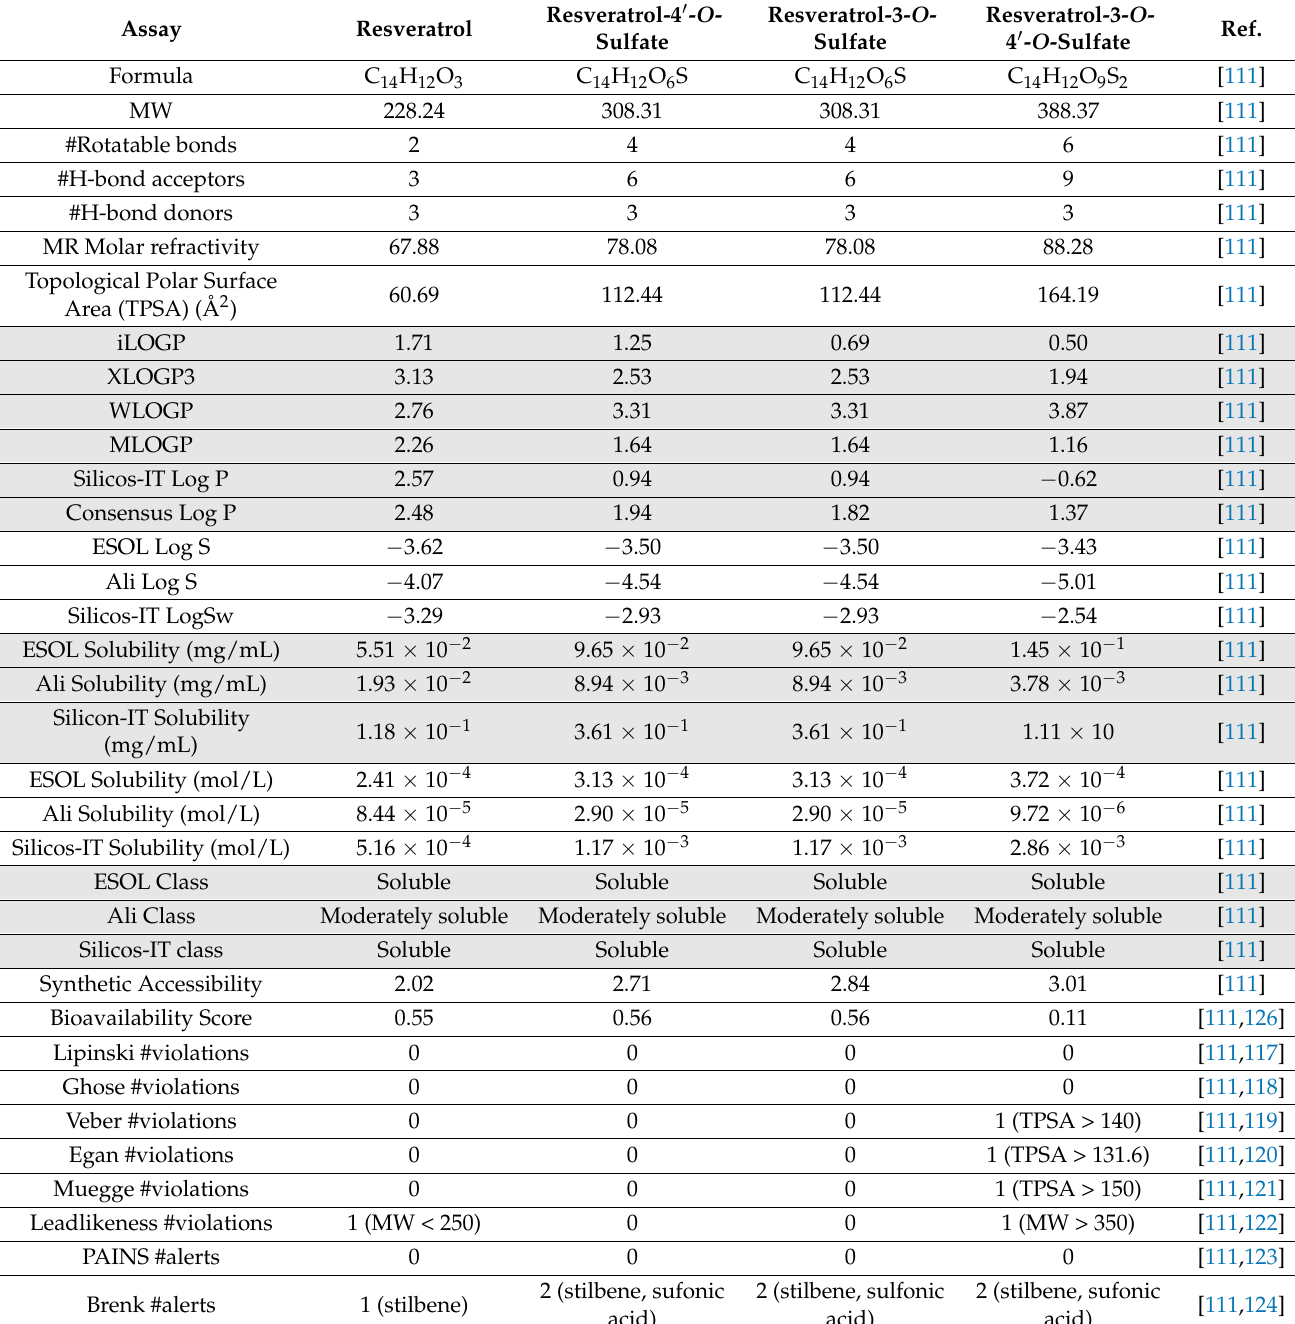
Table 4. The basic topological parameters of resveratrol and its sulfates are calculated using free web-based programs. Reference [111] corresponds to